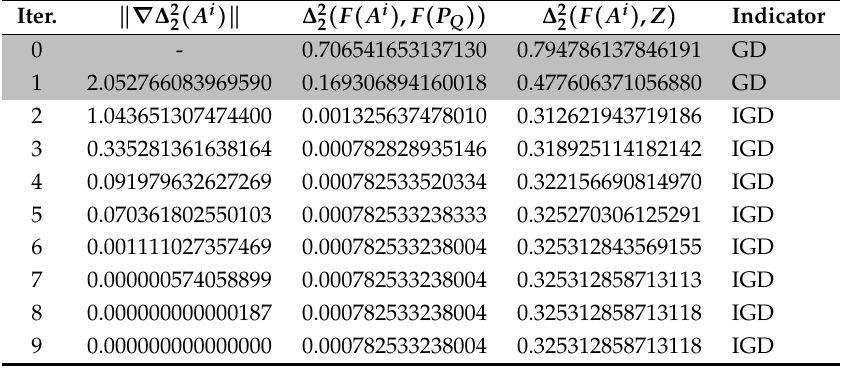
-Newton method on BOP (51), see Figure 13. 2